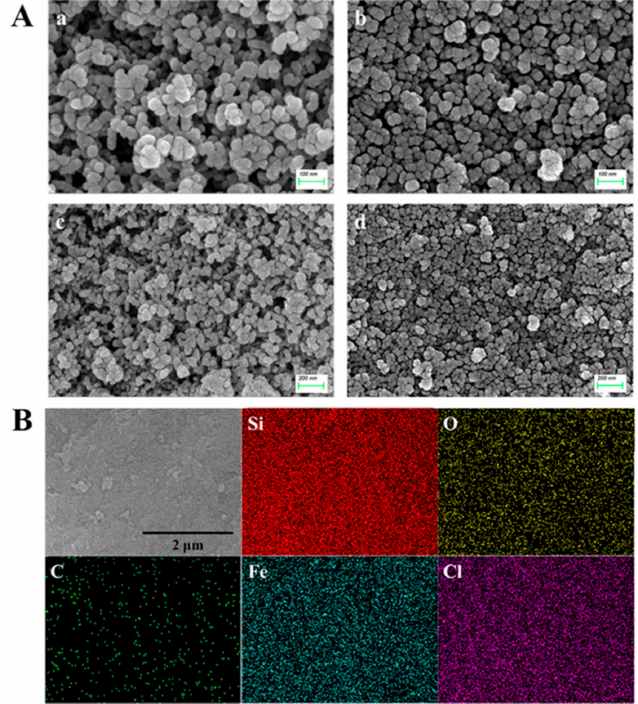
Figure 2. SEM images of the BMMs ( A -a, A -c) and Pro@BMMs − PMAA/Fe 3+ ( A -b, A -d) and